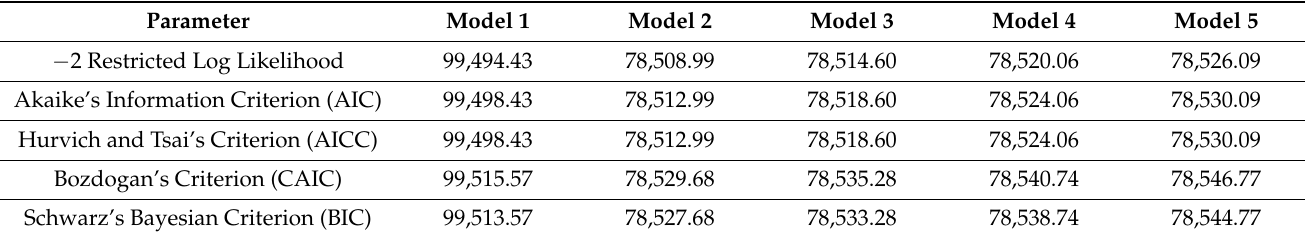
Table 3. Parameters of model